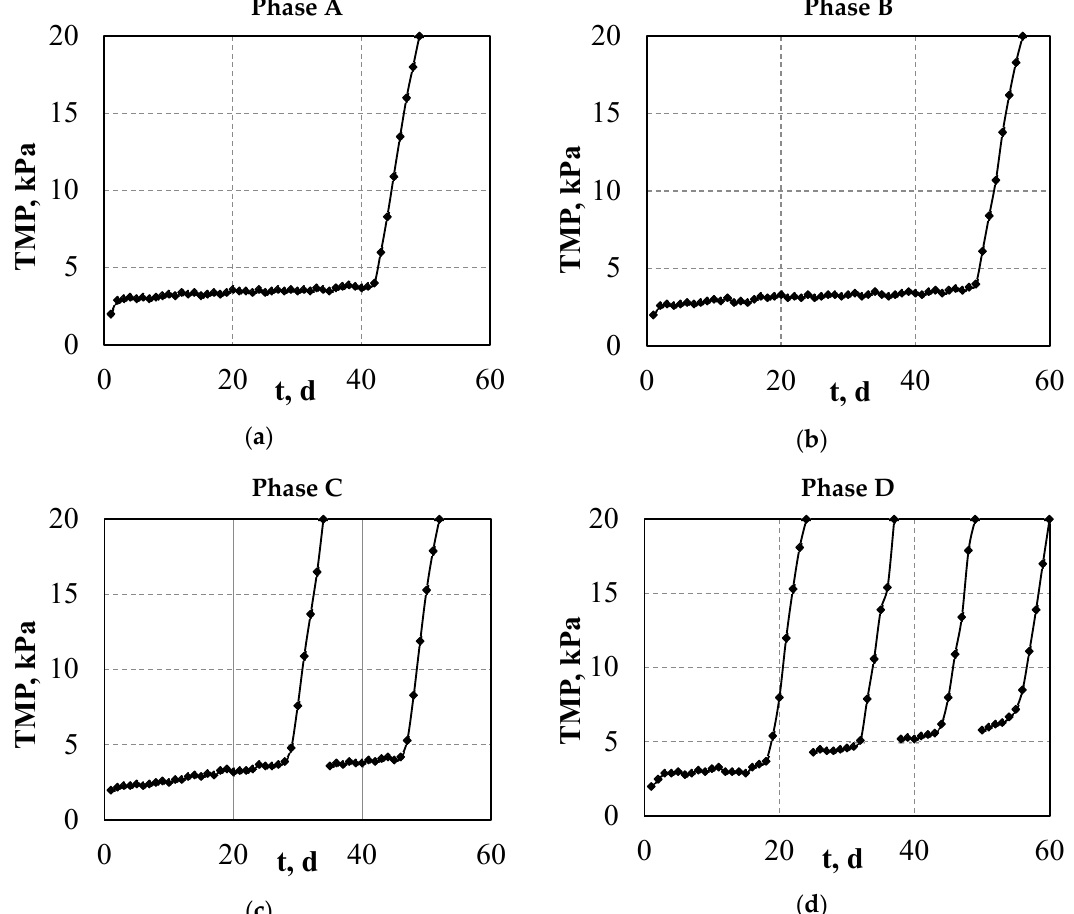
Figure 4. Effect of Filament Index (FI) and temperature on TMP during: ( a ) Phase A; ( b ) Phase B; ( c ) Phase C; ( d ) Phase D.